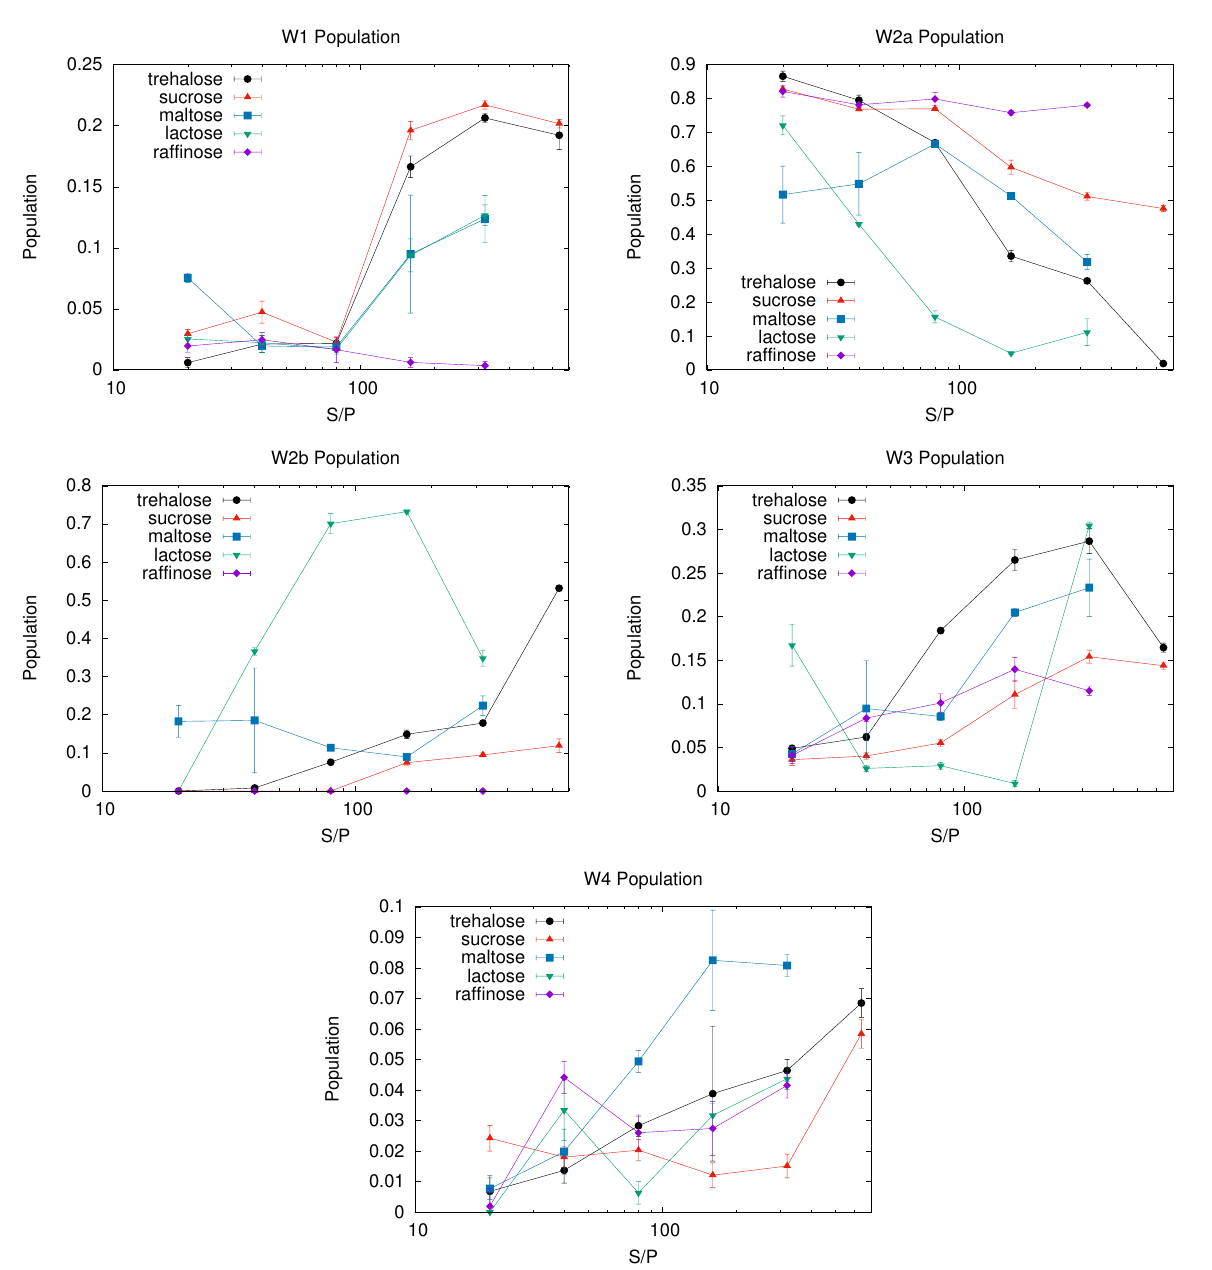
Figure 6. Population of various sub-bands. Vertical bars are standard deviations on the population. W1 is attributed to water in a chaotropic environment, mostly in the sugar domain: its population indeed increases with the sugar:protein ratio, with the exception of raffinose. W2a,b corresponds to bulk-like water present in the protein (W2a) and sugar domains (W2b), respectively: accordingly, W2a decreases with the sugar content while W2b increases, at least in trehalose, maltose and to some extent also in lactose. W3 and W4 correspond to more structured water, and are predominant at high sugar content: their population increase with the sugar:protein ratio, depleting the W2a,b